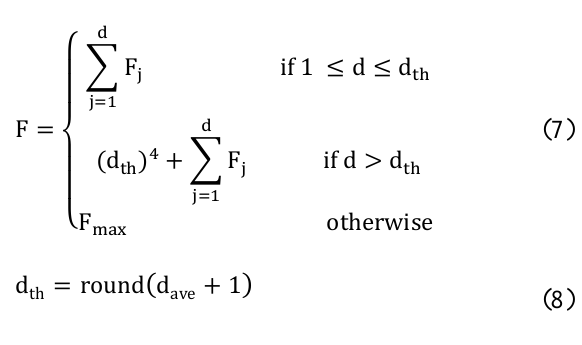
Figure 4. Desirable distance of AUVs from each